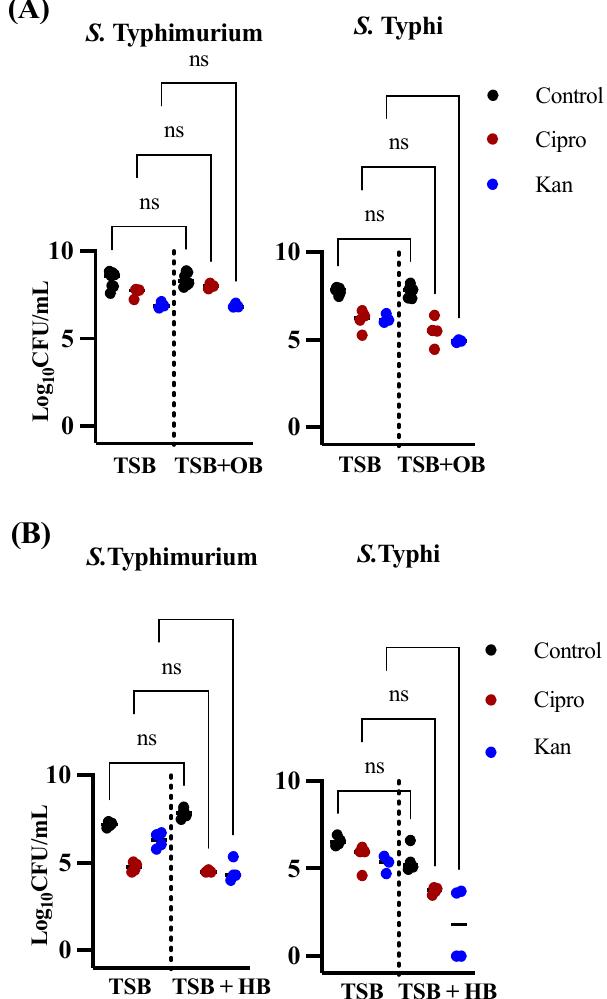
Figure 2. Persister cells recovered in S . Typhimurium 14028 and S . Typhi Ty2 laboratory strains after treatment with ciprofloxacin (red circles) or kanamycin (blue circles) in biofilms growing in ox bile ( A ) or human bile ( B ) versus total cells (strains not treated with antibiotics are represented by black circles). Representative charts are shown from one experiment performed with four or more biological replicates and repeated at least three times with similar results. A one-way ANOVA followed by Tukey’s multiple-comparison test were used to compare the different conditions (ns, not significant).